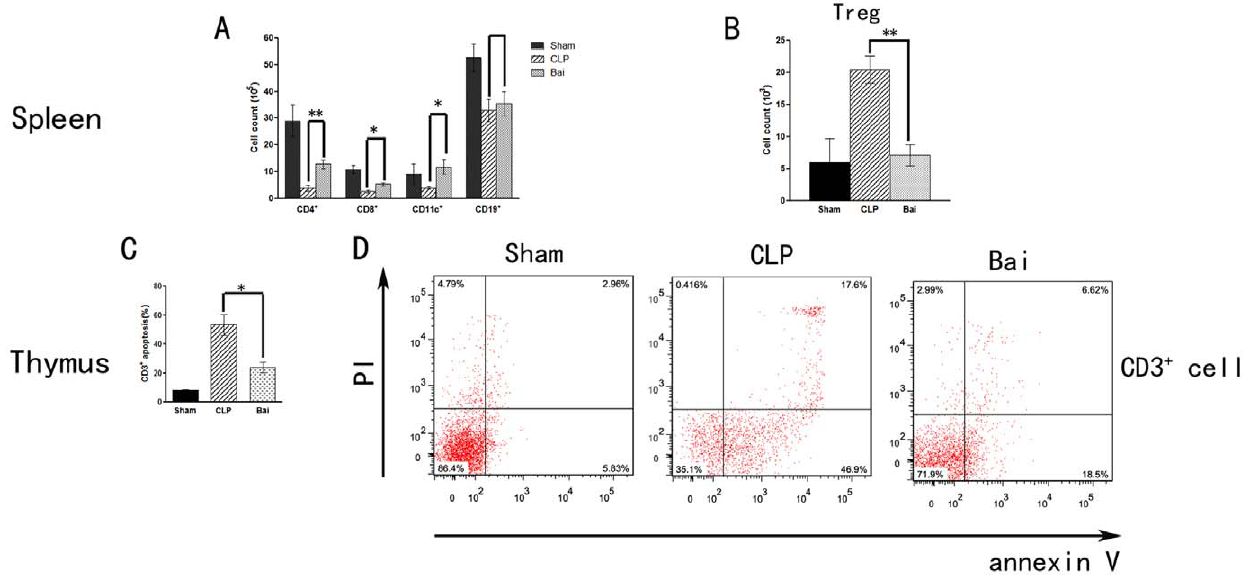
Figure 6. Cell counts in the spleen and apoptosis in the thymus in septic mice after baicalin administration. (A) Baicalin increased the numbers of CD4 + and CD8 + T lymphocytes, as well as CD11c + dendritic cells, but not CD19 + B lymphocytes in spleen. (B) Baicalin reduced the number of regulative T cells in spleen. (C, D) Baicalin inhibited lymphocyte apoptosis in thymus. Bai, baicalin group; CLP, CLP group. Data analyses with one- way ANOVA and Newman-Keuls. * P , 0.05, ** P , 0.01.